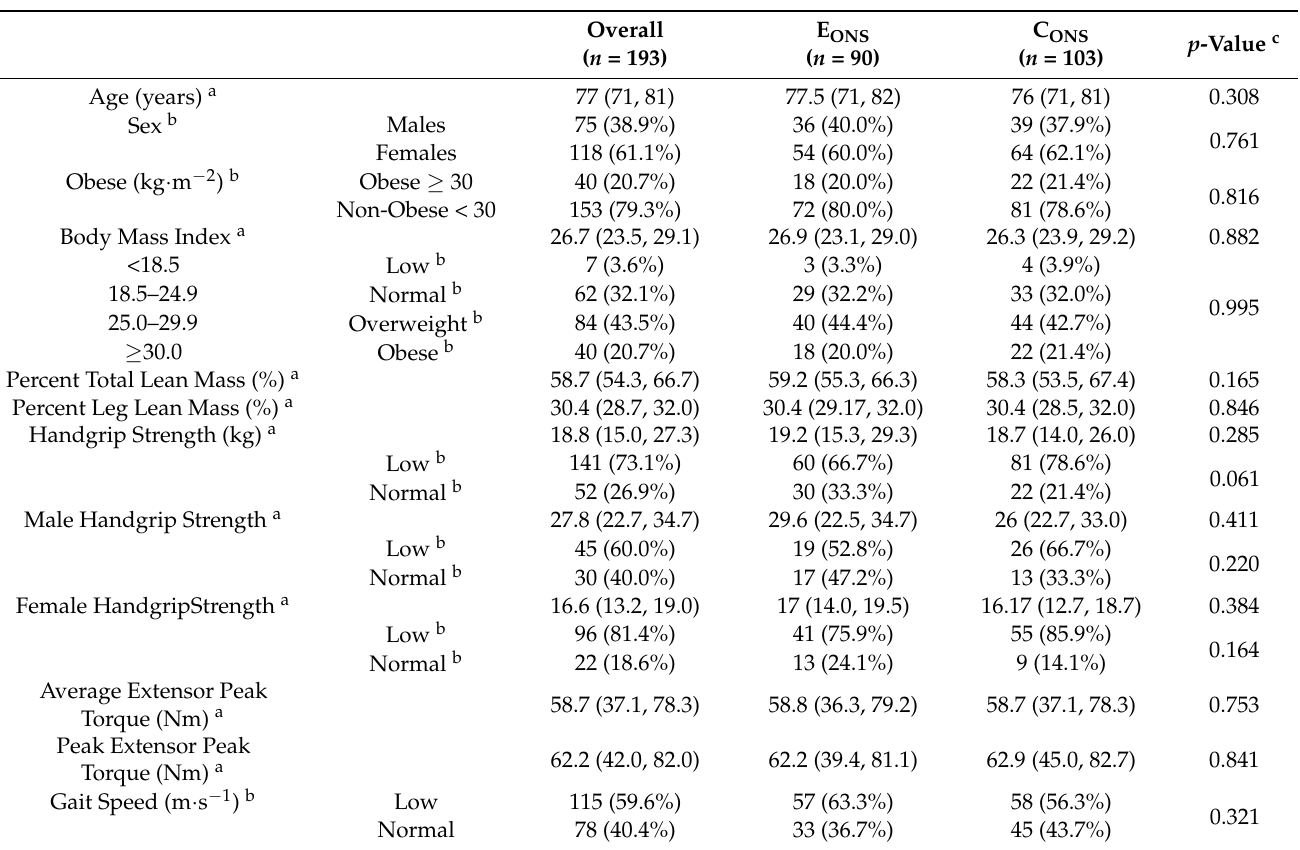
Table 1. Baseline characteristics of study population used for biomarker